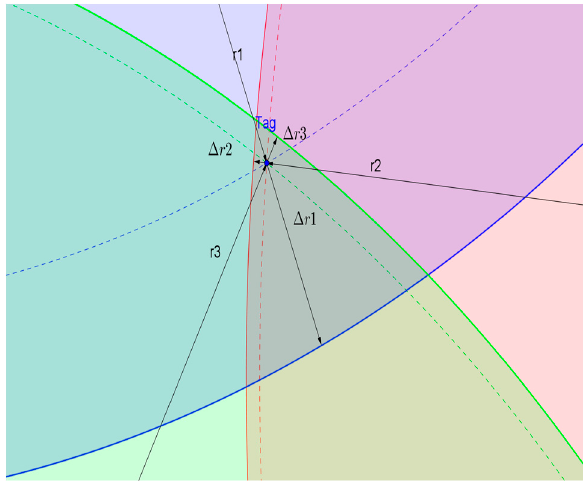
Figure 3. Position estimation by trilateration with measurement error.